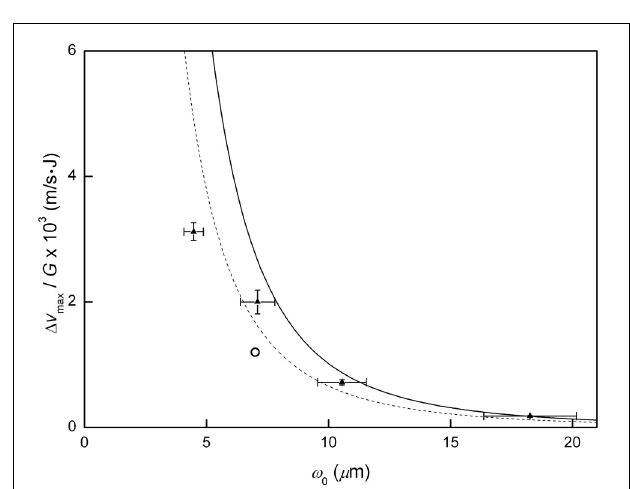
FIGURE 3 | The relationship between the beam waist radius and focal length. The measured data are denoted by the circles. The solid line is a plot of Equation (2) with M 2 = 1 and the dotted line with M 2 = 1 . 5.